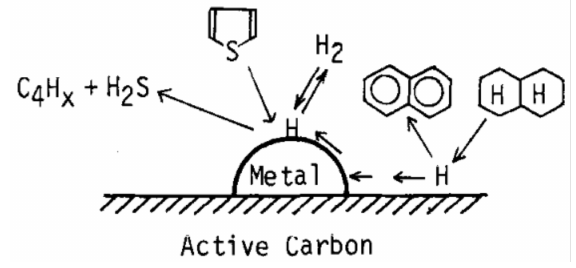
Figure 4. Reaction model of transfer